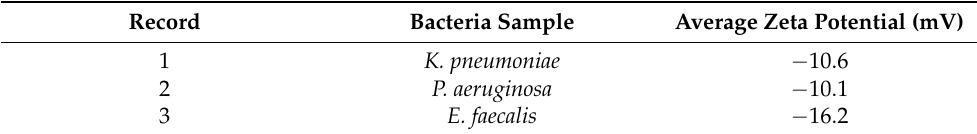
Table 2. The zeta potential around the surface of bacterial samples from dynamic light scattering. Record